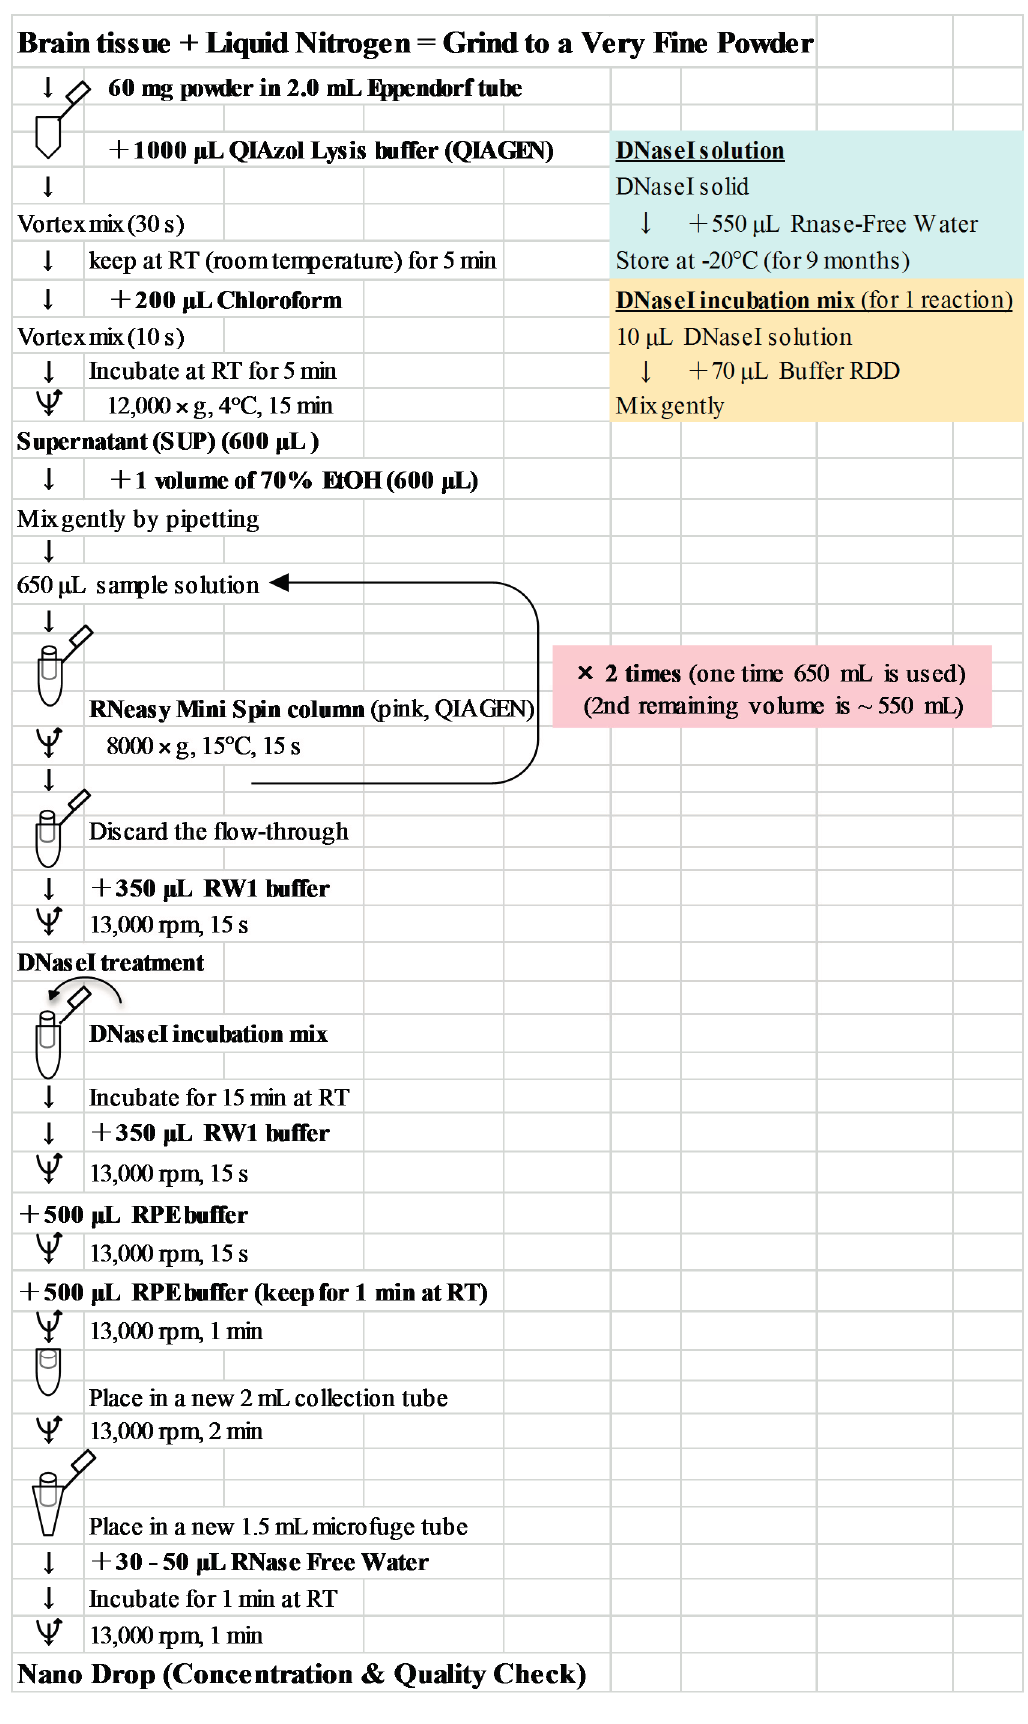
Figure 7. Illustrated protocol for extraction of total RNA from the brain